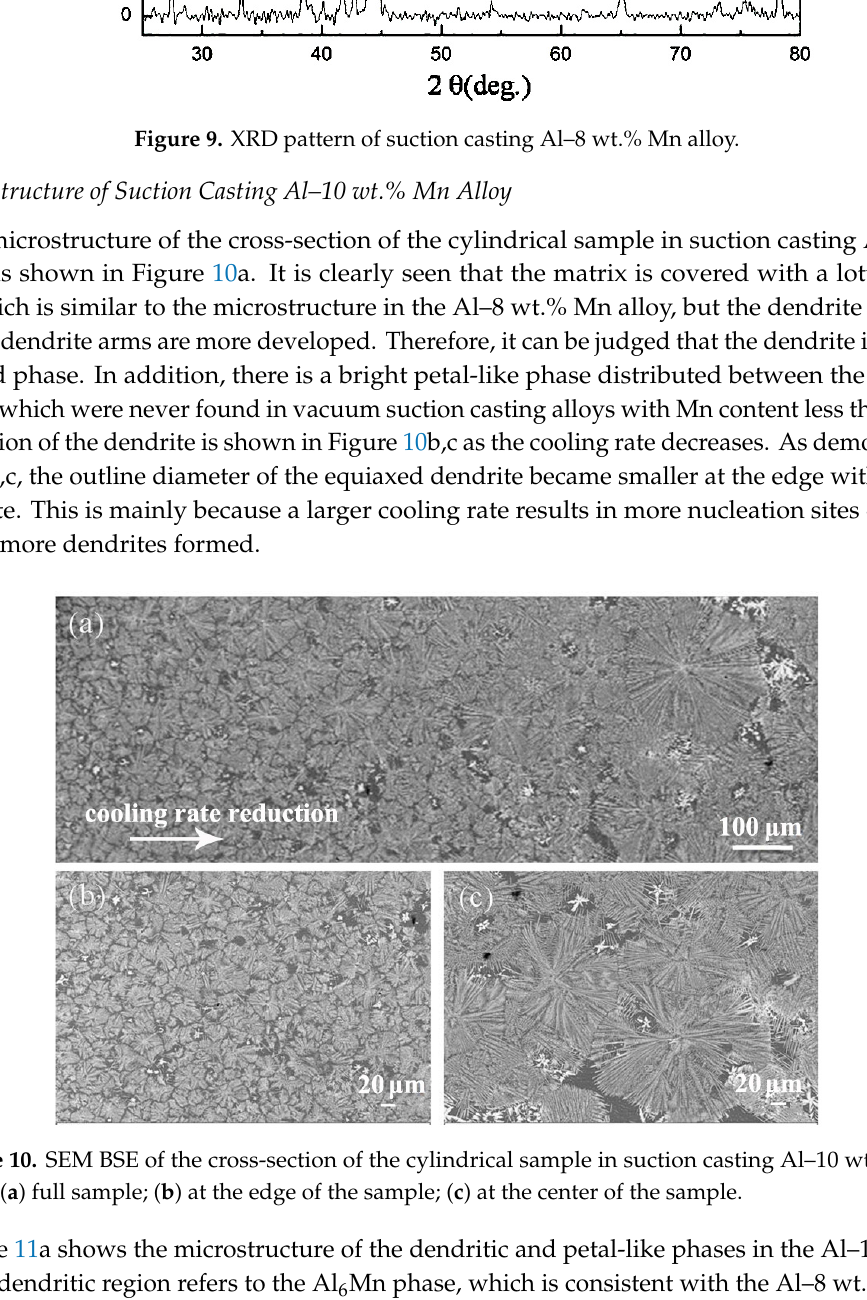
Figure 9. XRD pattern of suction casting Al–8 wt.% Mn alloy.